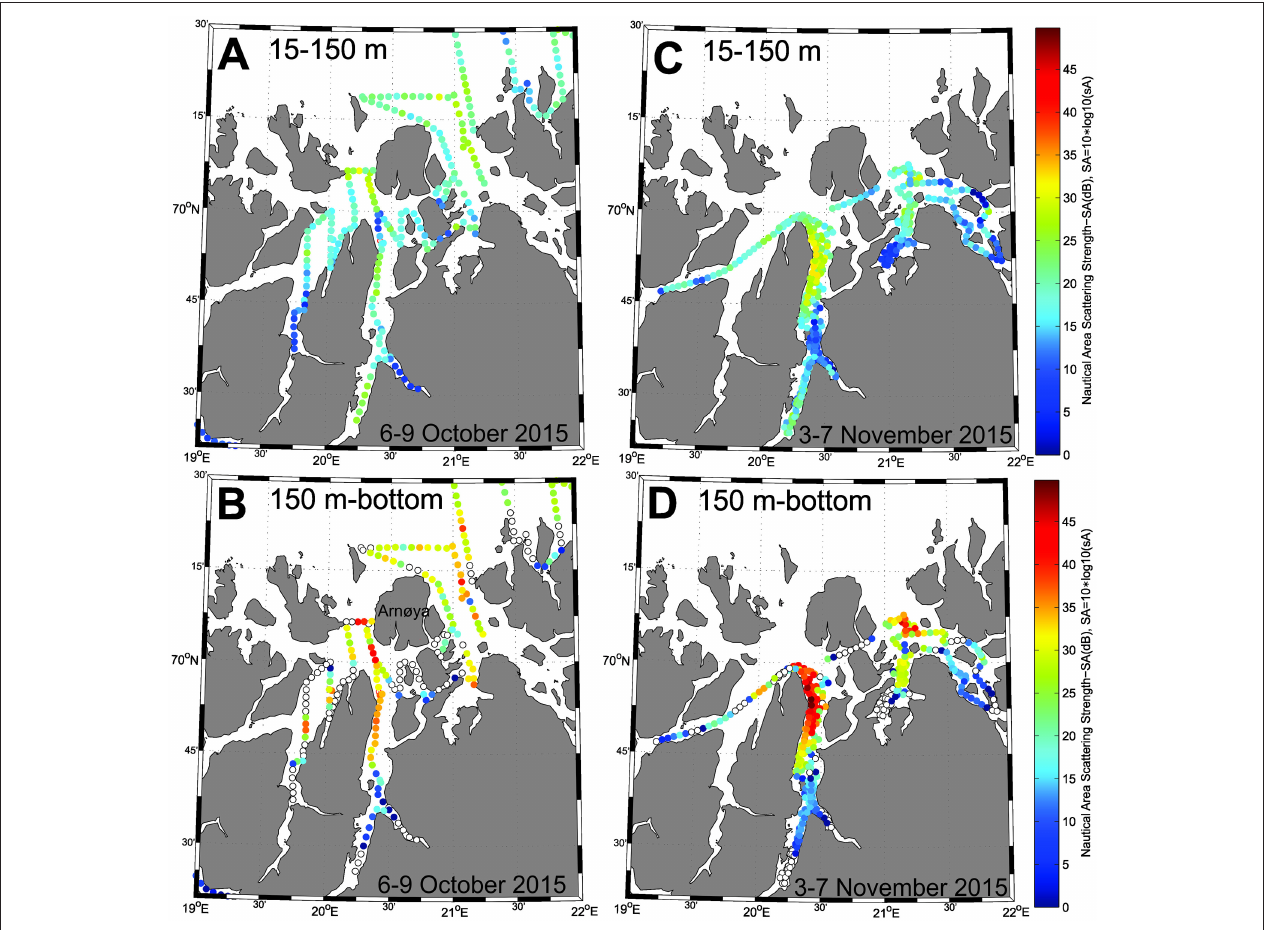
FIGURE 8 | (A,B) Acoustic registrations per 1 nmi cruise track scrutinized as Plankton, 6–9 October 2015 with RV Håkon Mosby. (C,D) Acoustic registrations per 1 nmi cruise track scrutinized as Plankton, 3–7 November 2015 with RV Helmer Hanssen. (A,C) Integrated values of s A (m 2 · nmi − 2 ) between 15 and 150m depth. (B,D): Integrated values of s A (m 2 · nmi − 2 ) between 150m and bottom. Data presented as nautical area scattering strength (S A , dB re 1 m 2 · nmi − 2 ), S A = 10log 10 (s A ). Open white circles in panel (B,D) represent locations where bottom depth is shallower than 150m, thus containing no acoustic data.